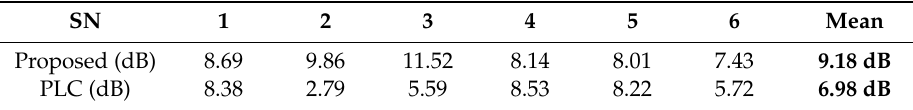
Table 9. RRSs of the false targets in green boxes.